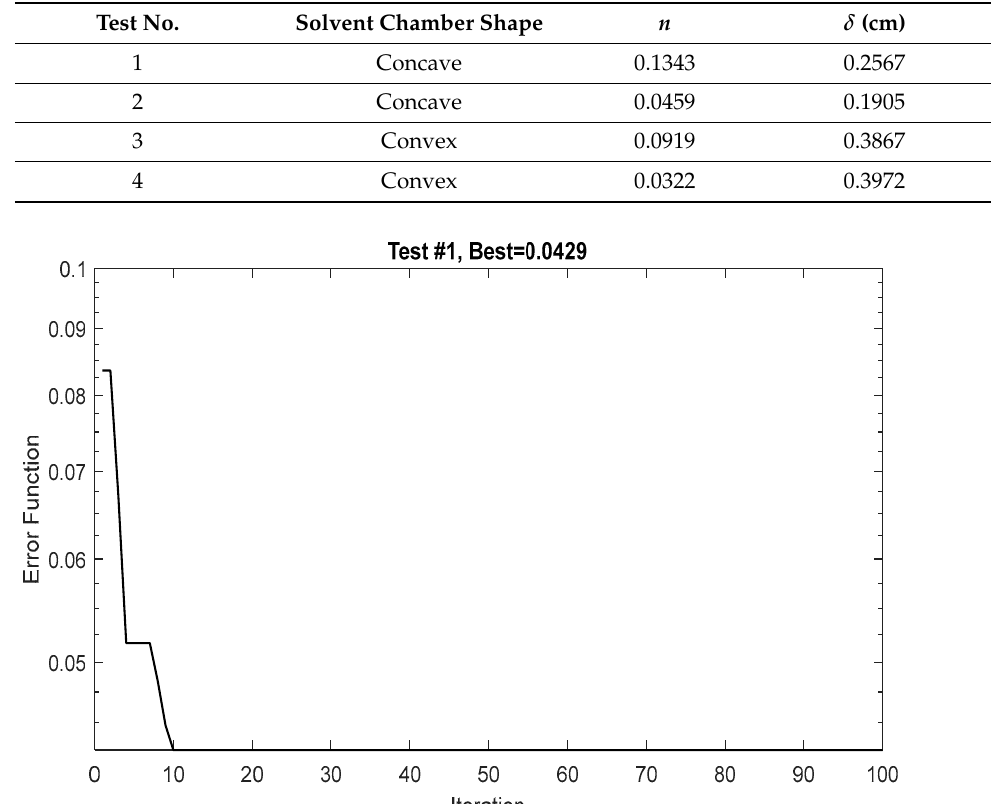
Figure 12. Variation in the error function at each iteration of the Genetic Algorithm in test #1.